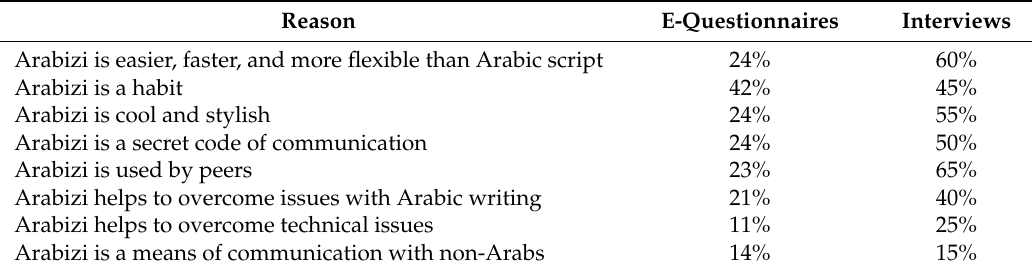
Table 2. The reasons for using